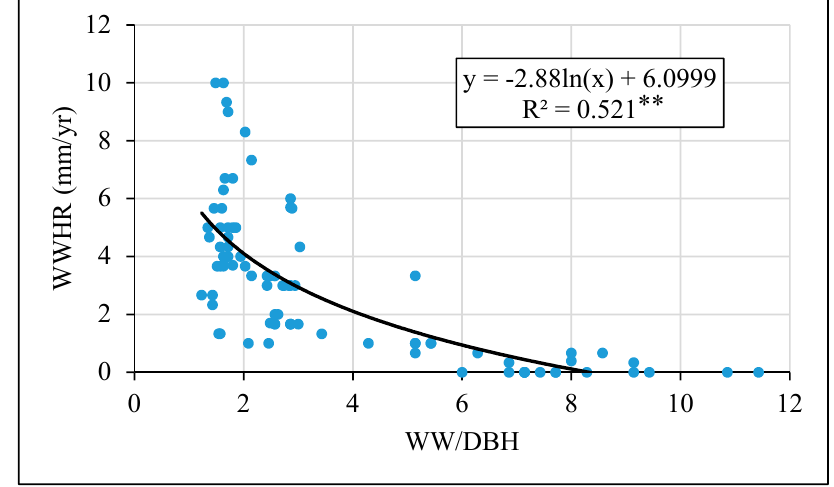
Figure 6. Relationship between wound width healing rate (WWHR) and wound wideness ratio (WW /